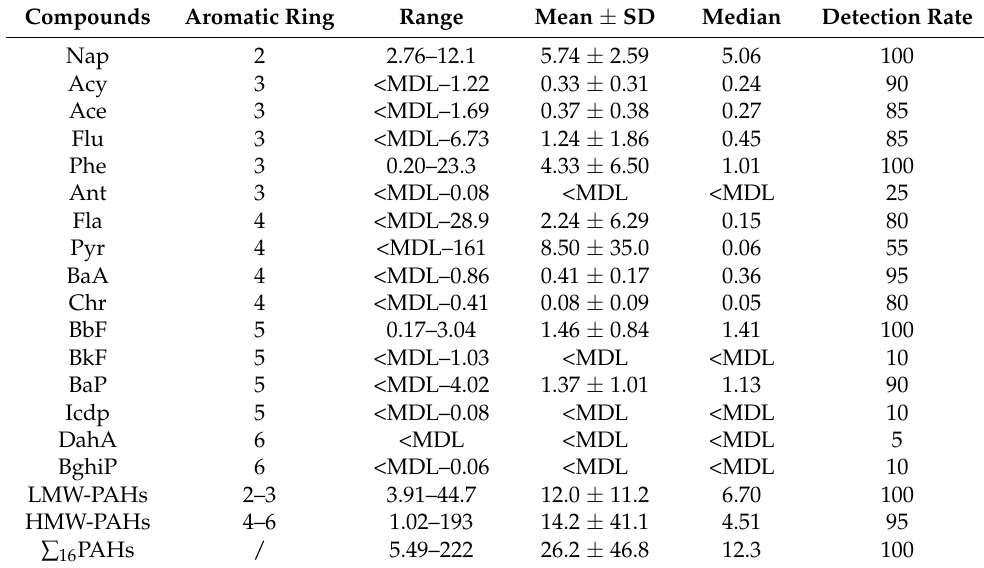
Table 2. Concentrations (ng · L − 1 ) and detection rates (%) of PAHs in the Danshui